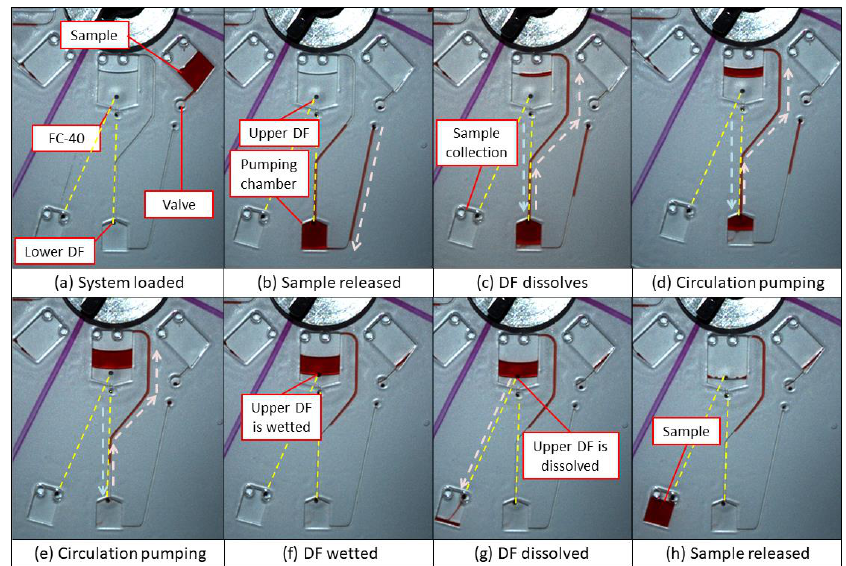
Figure 5. Recirculating pumping. ( a ) Disc cartridge in the initial configuration. At the start, non- aqueous FC-40 is restrained by the lower DF from entering the pumping chamber and by the upper DF from entering the collection chamber. The sample is restrained behind a DF burst valve. Con- necting channels on the underside of the disc are shown with dashed yellow lines. ( b ) The spin rate is increased and centrifugally drives the sample into the pumping chamber. ( c ) The lower DF is wetted to pneumatically release the FC-40. ( d , e ) The recirculating flow is powered by the centripetal displacement of the sample containing the higher-density FC-40. This process continues until hy- drostatic equilibrium is reached. ( f ) The upper DF is wetted by the (aqueous) sample and dissolves. ( g , h ) The sample is released to the collection chamber representing further LUOs. Note that in the experiment above, the volumes of FC-40 were tailored to minimise both the amount of FC-40 passed to the collection chamber and the volume of sample lost during pumping. Proper reduction of this FC-40 volume permits metering of the sample in the upper chamber (see also Video S3 and S4 in the ESI). 3.5. Sample Aliquoting As mentioned previously, DF-mediated buoyancy pumping can also allow a sample to be evenly and accurately split and metered and the excess sample will be returned through the loading channel. To demonstrate this capability, a combined aliquoting/me- tering/pumping structure is developed. This design is composed of four inverted pockets where three identical, defined pockets effectuate aliquoting and the fourth structure acts effectively as a waste or ‘overflow’ chamber. In this approach (Figure 6), the sample is pumped into the metering structure and the DF is dissolved to initiate pumping. In the ideal case, the sample should fully occupy the metering structures before the DF dissolves (Figure 6c). As the FC-40 is released, the larger waste chamber is filled with the sample until the sample is discretised (Figure 6d). Here, the sample is pumped inwards and accurately aliquoted (Figure 6e,f).